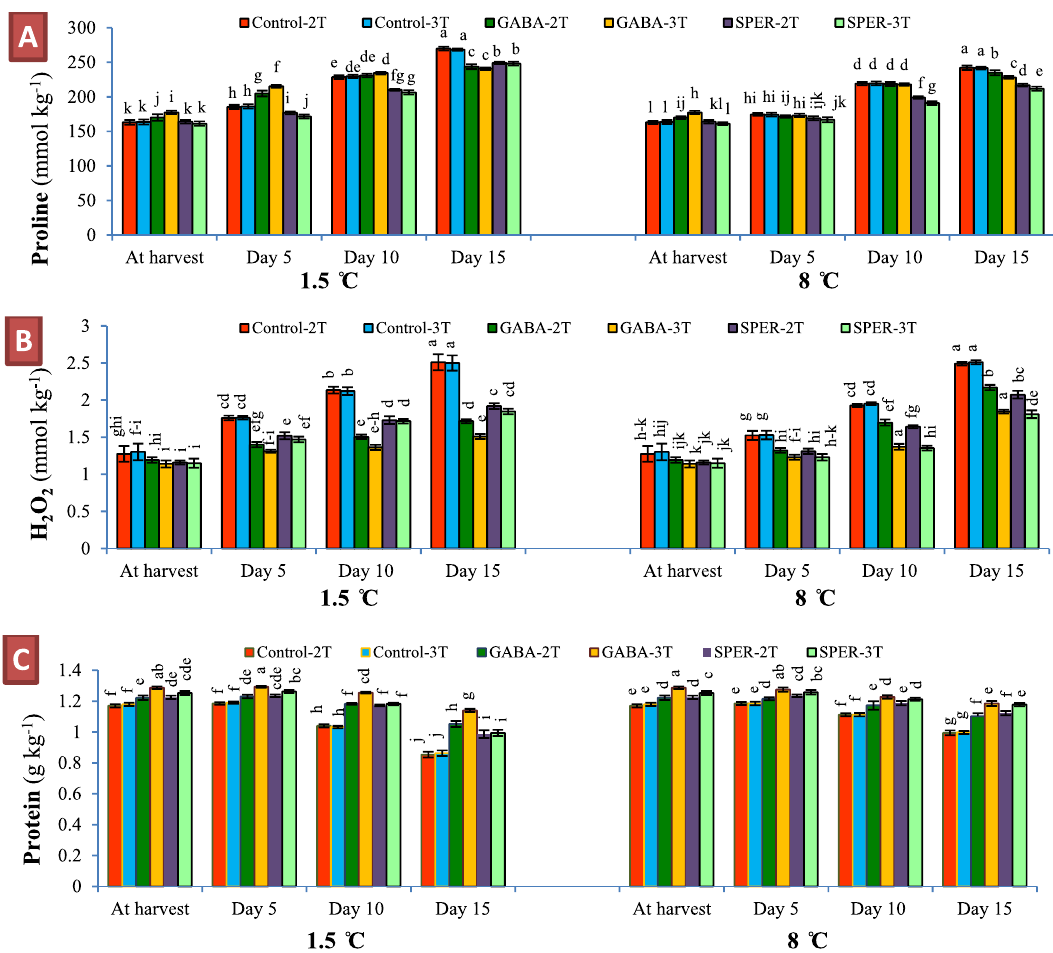
Figure 5. Free proline ( A ), hydrogen peroxide (H 2 O 2 ) ( B ) and total protein ( C ) contents in gerbera ‘Stanza’ cut flowers pre-harvest treated with GABA and SPER, during cold storage at 1.5 °C and 8 °C. 2 T and 3 T represent number of times the GABA and SPER are sprayed on intact gerbera plants at pre-harvest. Values are mean SE, n = 4. The bars marked with the same letters are not significantly different at p < harvest GABA- and SPER-treated flowers showed higher total protein content than pre-harvest water-sprayed controls, revealing less protein degradation. On day 15, the largest amounts of proteins were detected in cut flowers sprayed with GABA-3 T and kept at 1.5 °C (1.14 g kg −1 ). At 8 °C, the largest amounts of proteins were detected in cut flowers treated with GABA-3 T (1.18 g kg −1 ) and SPER-3 T (1.17 g kg −1 ) (Fig. 5C, Supplementary Fig. S4C). Antioxidant enzyme activity. Activity of ROS-scavenging system in gerbera cut flowers significantly affected by GABA and SPER treatments during cold storage. The CAT activity dropped drastically in water- sprayed controls with the progressing senescence over time at both 1.5 °C and 8 °C. On day 15, the lowest CAT activity was observed in cut flowers sprayed with water (Control-2 T and Control-3 T). In GABA- and SPER- treated flowers, the CAT activity increased slightly approx. 1.1 times during day 0 and 5 and then decreased dur- ing the following 10 days, but remained at a higher level than the controls. Storage stimulated the CAT activity in treated cut flowers, at the start of the vase life. The highest CAT activity was observed in GABA-3 T (147 U kg −1 ) and GABA-2 T (137 U kg −1 ) treated flowers stored at 1.5 °C. The highest CAT activity was observed in SPER-3 T (154 U kg −1 ) and GABA-3 T (148 (U kg −1 ) at 8 °C respectively (Fig. 6A, Supplementary Fig. S5A). Analyses done immediately after harvest and on day 5 showed no significant changes in POD activity at 1.5 °C and 8 °C. POD activity then dropped drastically (approx. up to 3 times) in water-sprayed flowers over time. In GABA- and SPER-treated flowers, the POD activity decreased more slightly approx. 1.2–1.5 times at 1.5 °C and 1.3–1.8 times at 8 °C during day 5 and 15 and remained at a higher level than the controls (Fig. 6B, Supplementary Fig. S5B). SOD activity increased approx. 1.3 times during day 0 and 5 in water-sprayed controls at both 1.5 °C and 8 °C. Its activity then dropped drastically (approximately 2–3 times at 8 °C and 1.5 °C respectively) with the progress- ing senescence over time. SOD activity in GABA- and SPER-treated flowers revealed a significant decrease 15